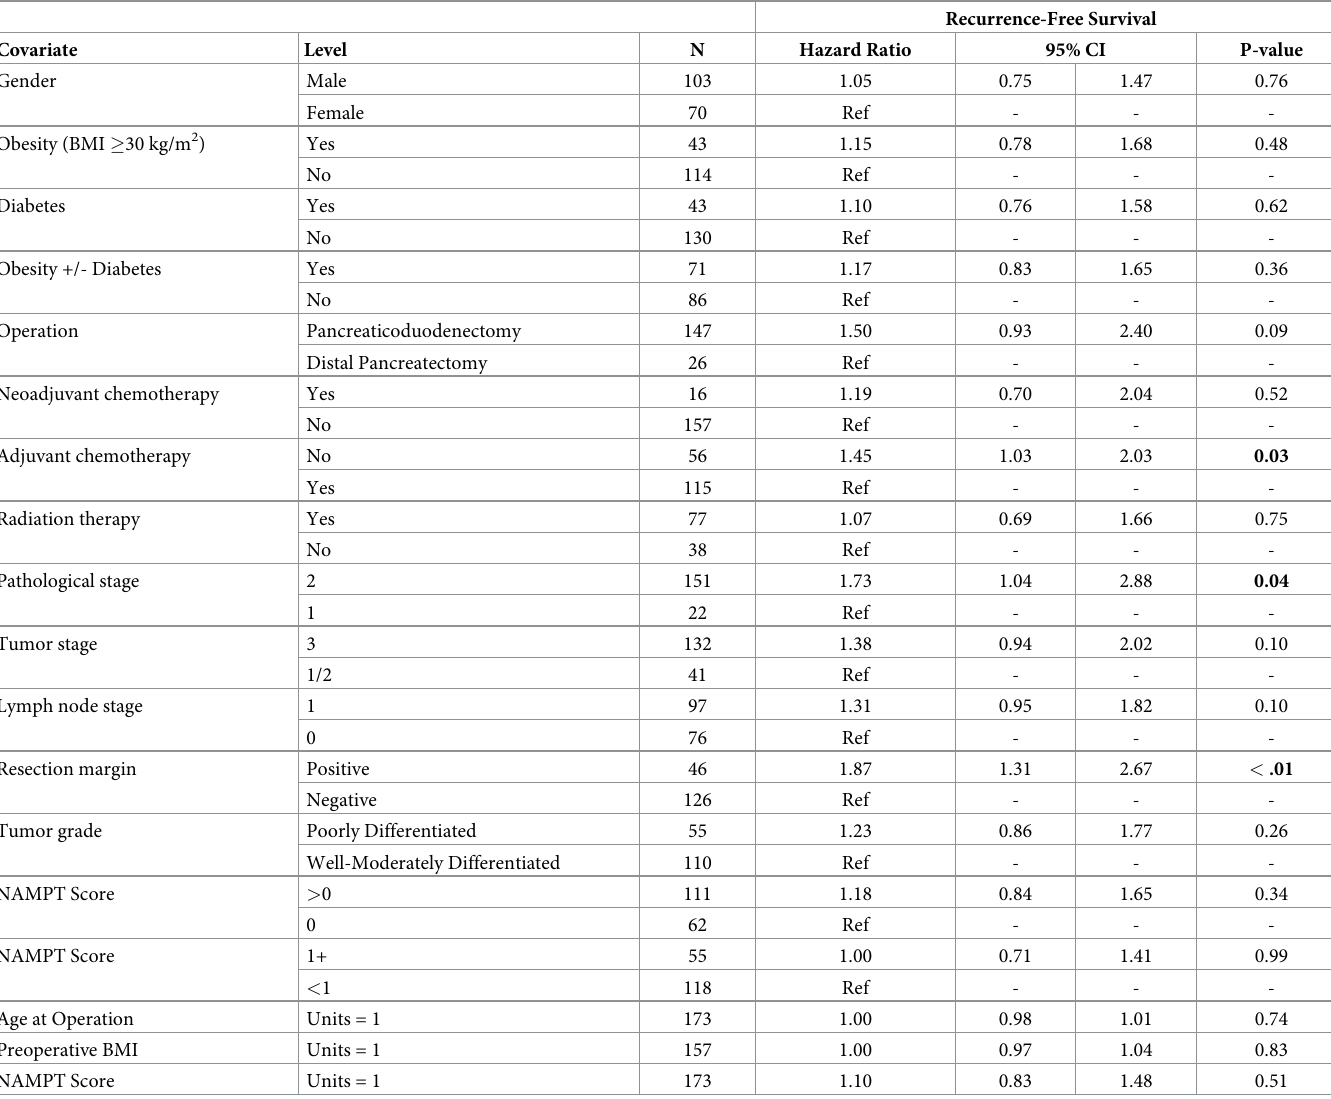
Table 3. Univariate analysis for recurrence-free